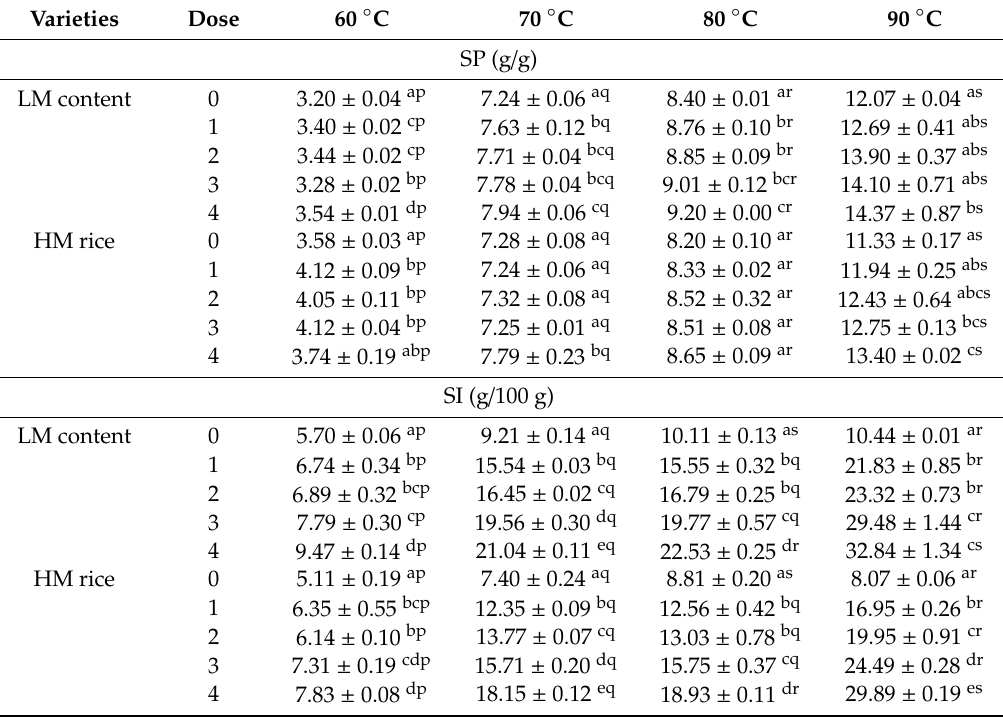
Table 1. Swelling power and solubility index of control and irradiated rice flours *.